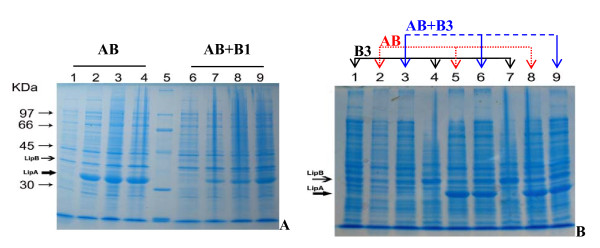
SDS-PAGE of BL21 cell lysates using two-plasmid co-expression system. (A). pELipABa (1-4), pELipABa + pELipB1k (6-9). Lanes (1-4) and (6-9) indicated induction by IPTG for 0, 1, 2, and 4 hours, respectively; Lane 5: standard protein. (B). pELipB3k (1, 4, 7), pELipABa (2, 5, 8) and pELipABa + pELipB3k (3, 6, 9). Lanes (1, 2, 3), (4, 5, 6), (7, 8, 9) indicated induction by IPTG for 0, 2, and 4 hours, respectively.